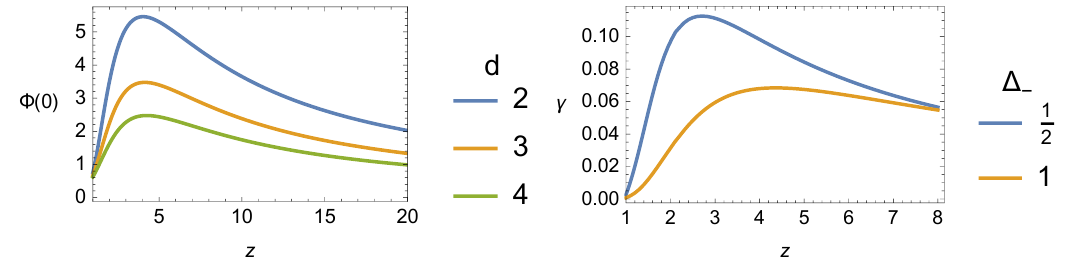
Figure 2 . The two coe(cid:14)cients (cid:8)(0) and (cid:13) in the expansion (3.3) as functions of dynamical exponent z . In the right plot, spatial dimension is d =